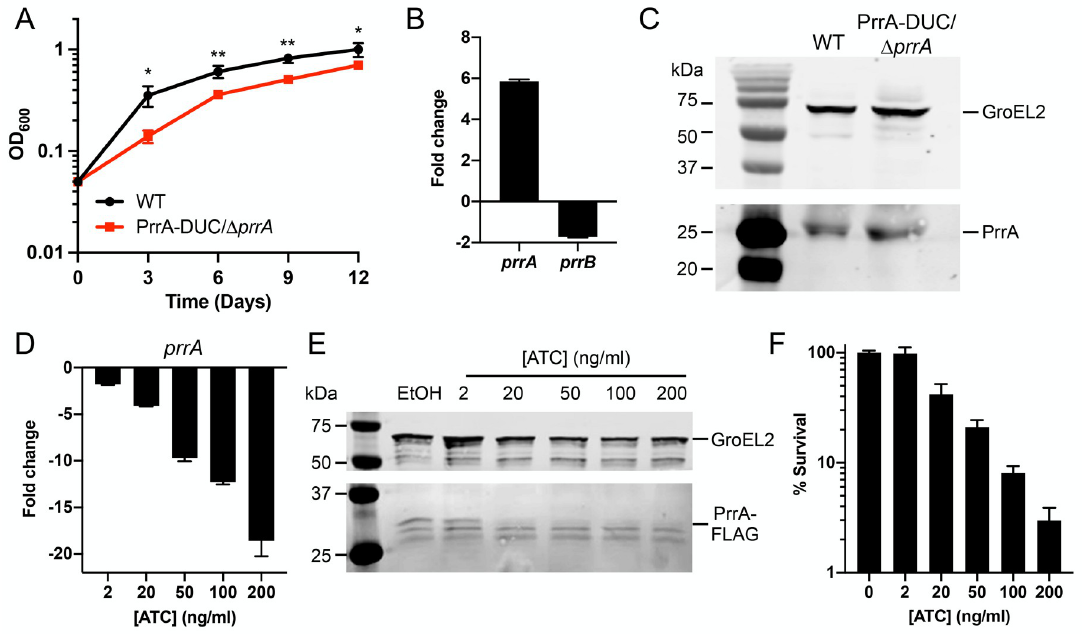
Fig 4. Characterization of dual inducible prrA gene repression/PrrA protein degradation system. (A) PrrA-DUC/ Δ prrA Mtb grows more slowly than WT Mtb. WT or PrrA-DUC/ Δ prrA Mtb were grown in 7H9, pH 7.0 media and growth tracked over time. Data are shown as means ± SD from three experiments. p-values were obtained with an unpaired t-test, comparing the strains at each time point. � p < 0.05, �� p < 0.01. (B) PrrA-DUC/ Δ prrA Mtb has elevated prrA transcript levels compared to WT Mtb. qRT-PCR of WT or PrrA-DUC/ Δ prrA Mtb grown in 7H9, pH 7.0 for four hours. Fold change compares the PrrA-DUC/ Δ prrA strain to WT. sigA was used as the control gene, and data are shown as means ± SD from three technical replicates. (C) Elevated PrrA levels is detected by western blot in PrrA-DUC/ Δ prrA Mtb. WT or PrrA-DUC/ Δ prrA Mtb were grown in 7H9, pH 7.0 media for nine days. Cultures were normalized to the lowest OD 600 and lysates analyzed by western blot. Membranes were blotted with either anti-GroEL2 antibody as a loading control (top panel) or an anti-PrrA antibody (bottom panel). Blot is representative of 3 experiments. (D and E) ATC concentration-dependent repression of prrA expression in PrrA-DUC/ Δ prrA Mtb. (D) shows qRT-PCR data of prrA expression in PrrA-DUC/ Δ prrA Mtb grown in 7H9, pH 7.0 media and treated with 0.1% EtOH or indicated concentrations of ATC for six hours. Fold change compares each ATC-treated condition to the EtOH control. sigA was used as the control gene, and data are shown as means ± SD from three technical replicates. (E) shows western blot analysis of PrrA-DUC/ Δ prrA Mtb grown in 7H9, pH 7.0 media and treated with 0.1% EtOH or indicated concentrations of ATC for two days. Cultures were normalized to the lowest OD 600 before lysate preparation. Membranes were blotted with either an anti-GroEL2 antibody as a loading control (top panel) or an anti-FLAG antibody (bottom panel). Blot is representative of 2–3 experiments. (F) Viability of PrrA-DUC/ Δ prrA Mtb is affected in an ATC-concentration dependent manner. PrrA-DUC/ Δ prrA Mtb was treated with 0.1% EtOH (0 ng/ml ATC) or indicated concentrations of ATC for two days. Cultures were normalized to the lowest OD 600 and plated for colony forming units (CFUs). CFUs observed in the control 0 ng/ml ATC concentration was set at 100% survival. Data are shown as means ± SD from three